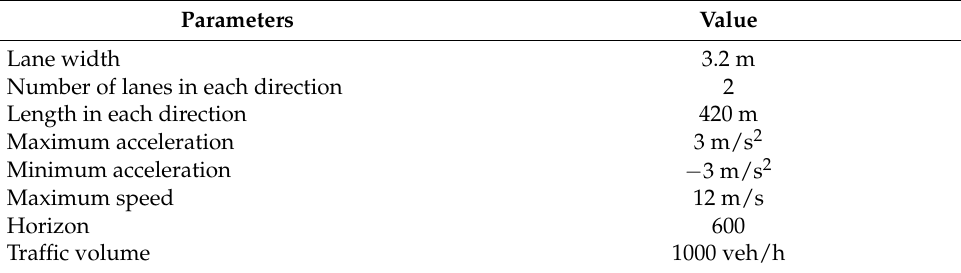
Table 3. Initialized parameters for the